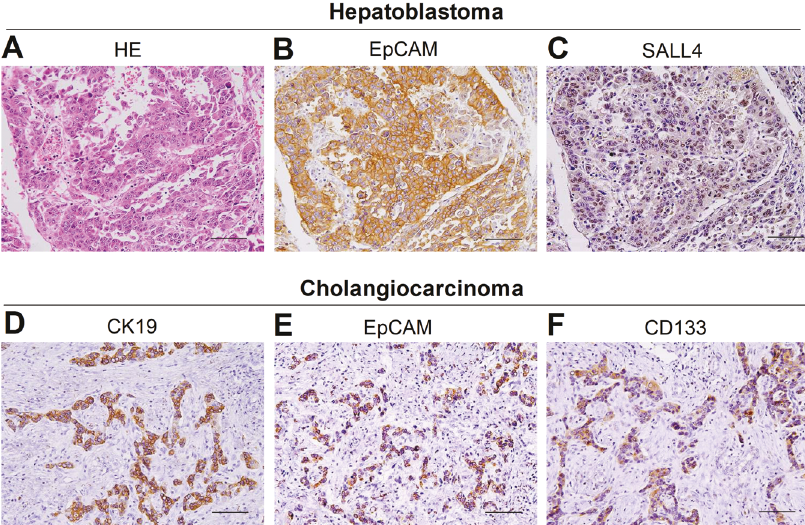
Fig. 1 HB and CCA are two kinds of liver cancer with remarkable stemness features. A HE and B , C IHC showed that stemness markers (EpCAM and SALL4) were positive in HB. D – F IHC showed that stemness markers (CK19, EpCAM, and CD133) were positive in CCA. HE hematoxylin-eosin staining, IHC immunohistochemical staining.